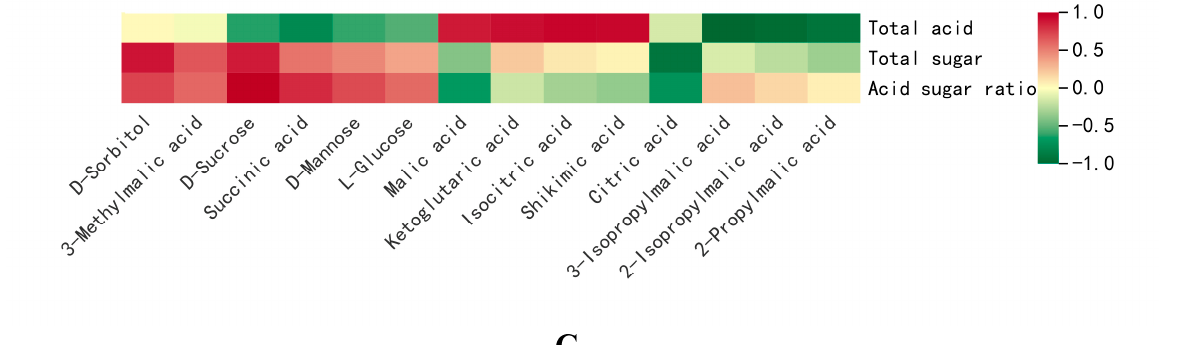
Figure 4. ( A ): The absolute content of soluble sugar (sucrose, fructose and glucose). ( B ): The absolute content of organic acid (citric acid and malic acid). ( C ): Correlation between fruit taste and sugar and organic acids during ‘Shushanggan apricot’ fruit development. The square color corresponds to the correlation value as shown in the legend: green represents a negative correlation and red represents a positive correlation. * represents significant difference at p < 0.05 level. ** represents significant difference at p < 0.01 level.